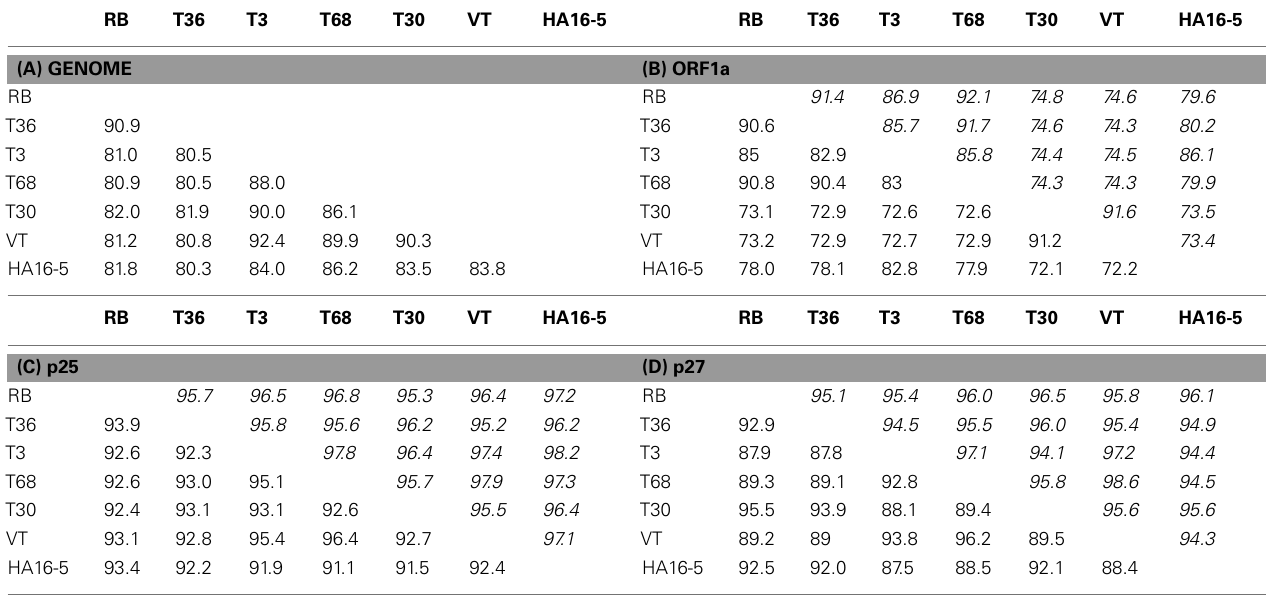
Table 2 |Average nucleotide and amino acid between strain identities for the (A) complete genome, (B) ORF1a, (C) p25, and (D) p27